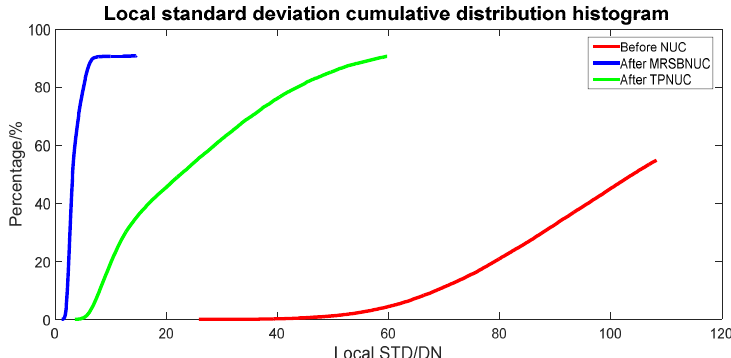
Figure 12. Local standard deviation cumulative distribution of clear sky scene: before NUC, after TPNUC, and after MRSBNUC.